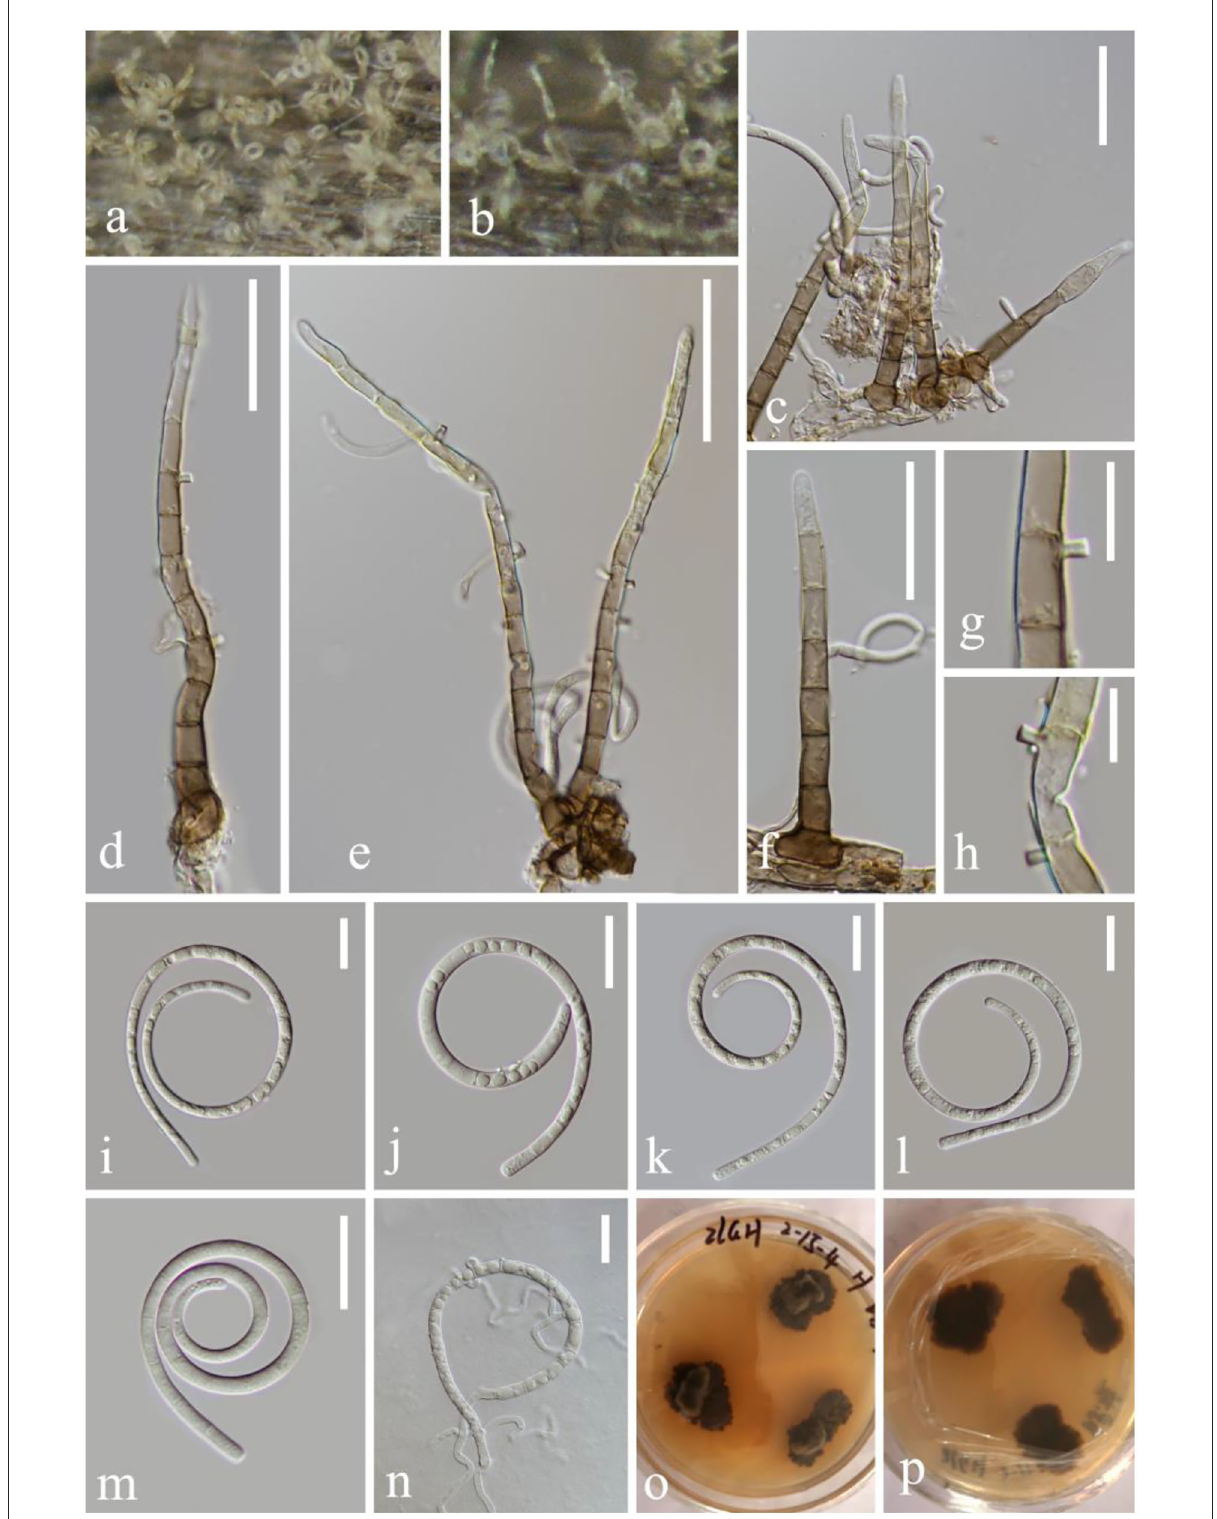
FIGURE2 Helicoma rugosum (KUN-HKAS 124608). (a,b) Colony on decaying wood. (c–f) Conidiophores with attached conidia. (g,h) Conidiogenous cells. (i–m) Conidia. (n) Germinating conidium. (o,p) Colony on PDA observed from above and below. Scale bars: (c,d) 30 µ m, (e) 50 µ m, (f) 30 µ m, (g,h) 10 µ m, and (i–n) 20 µ